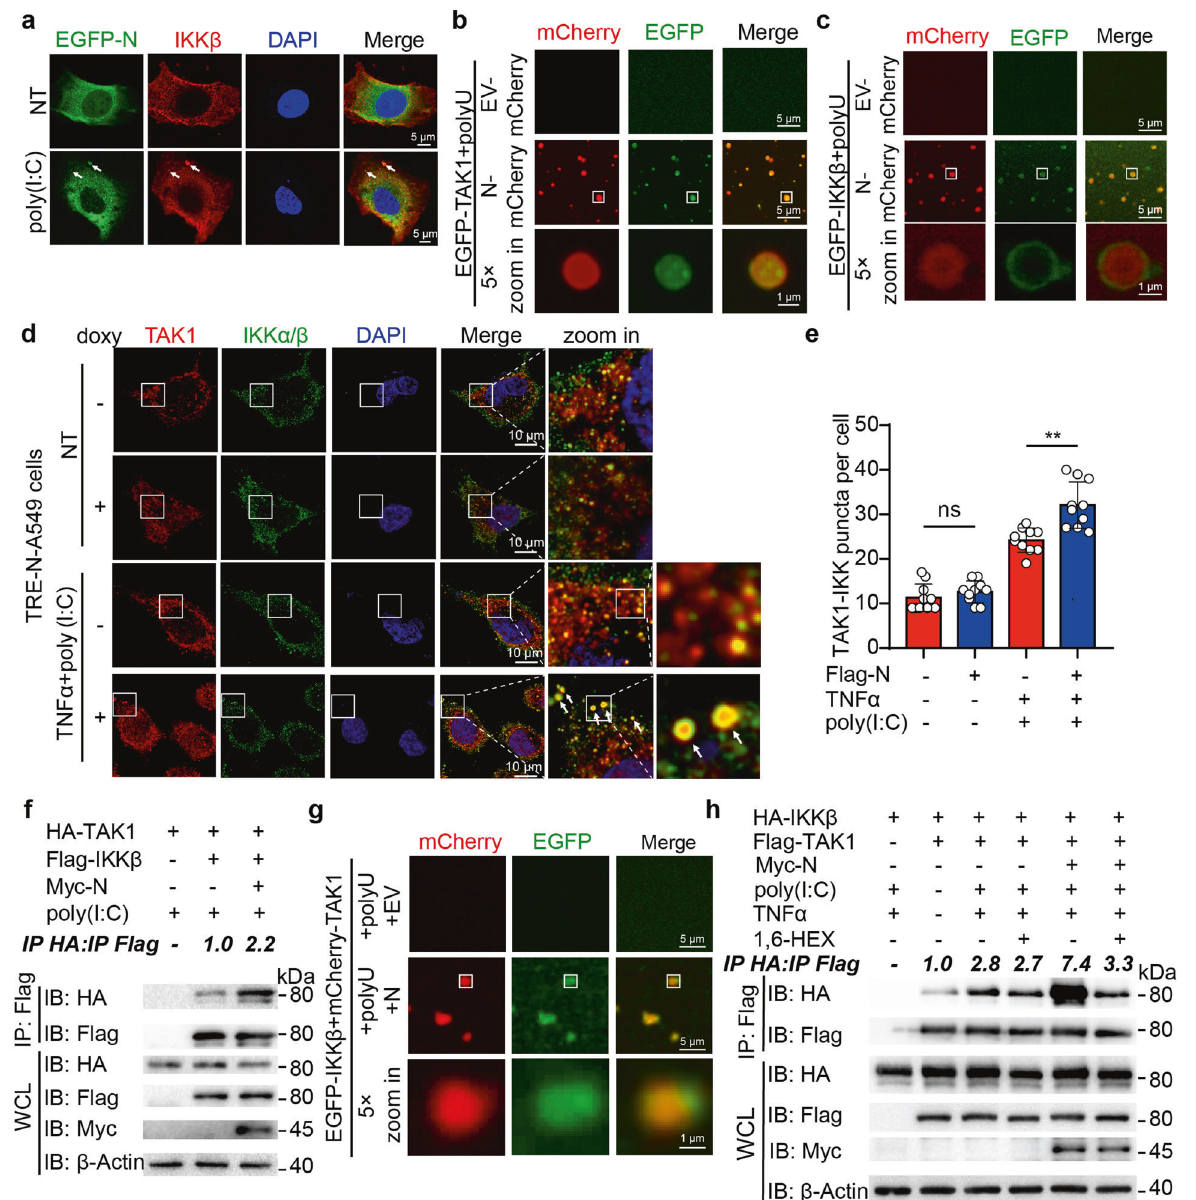
Fig. 4 LLPS of SARS-CoV-2 N protein recruits TAK1 and IKK complex. a Representative image of confocal micrographs of Huh7 cells stably expressing EGFP-N protein, treated with 1 μ g/mL poly(I:C) for 6 h, followed by labeling IKK β and DAPI. Scale bars, 5 μ m. b – c Representative images showing TAK1 ( b ) or IKK β ( c ) were distributed into N protein-polyU droplets in vitro. 10 μ M mCherry-N protein and 5 μ M EGFP-TAK1 ( b ) or EGFP- IKK β ( c ) were mixed with 10 ng/mL polyU and incubated at 37 °C for 10 min. Confocal 5× zoom-in of the area highlighted above was re-photographed. Scale bars, 5 μ m. d – e Representative images ( d ) of confocal microscopy of TRE-N-A549 with 200 ng/mL doxy treated for 24 h or left untreated, followed by 1 µg/mL poly(I:C) treatment for 6 h or left non-treated (NT). Cells were fi xed and labeled of TAK1 and IKK β . Scale bars, 5 μ m. Quantitative analysis ( e ) of the co-localization puncta (10 cells per sample). f HEK293T cells were transiently transfected HA-TAK1, Flag-IKK β and Myc-N, followed by 1 µg/mL poly(I:C) treatment for 6 h. The whole-cell lysates were collected for immunoprecipitation by anti- Flag beads and immunoblotting by indicated antibodies. The ratio of the gray value between IP-HA and IP-Flag was determined. g Representative images of the formation of N protein-TAK1-IKK β complex in vitro. 5 µM mCherry-TAK1 and EGFP-IKK β were mixed with 10 ng/ mL polyU and 10 μ M His-N protein or 10 μ M His-EV, then incubated at 37 °C for 10 min. Confocal 5× zoom-in of the area highlighted above was re-photographed. Scale bars, 5 μ m. h HEK293T cells were transfected with HA-IKK β , Flag-EV, Flag-TAK1, Myc-EV, and Myc-N protein with poly(I: C) and TNF α treatment, followed by 20 μ g/mL digitonin and 2.5% 1.6-HEX for 2 h before harvested. Cell lysates were collected for immunoprecipitation with anti-Flag beads and immunoblotting with indicated antibodies. The ratio of the gray value between IP-HA and IP- Flag was determined. Data in ( e ) are expressed as mean ± SD. ** p < 0.01, ns not signi fi cant (two-tailed Student ’ s t -test). For ( a – d ) and ( f – h ), similar results are obtained for three independent biological